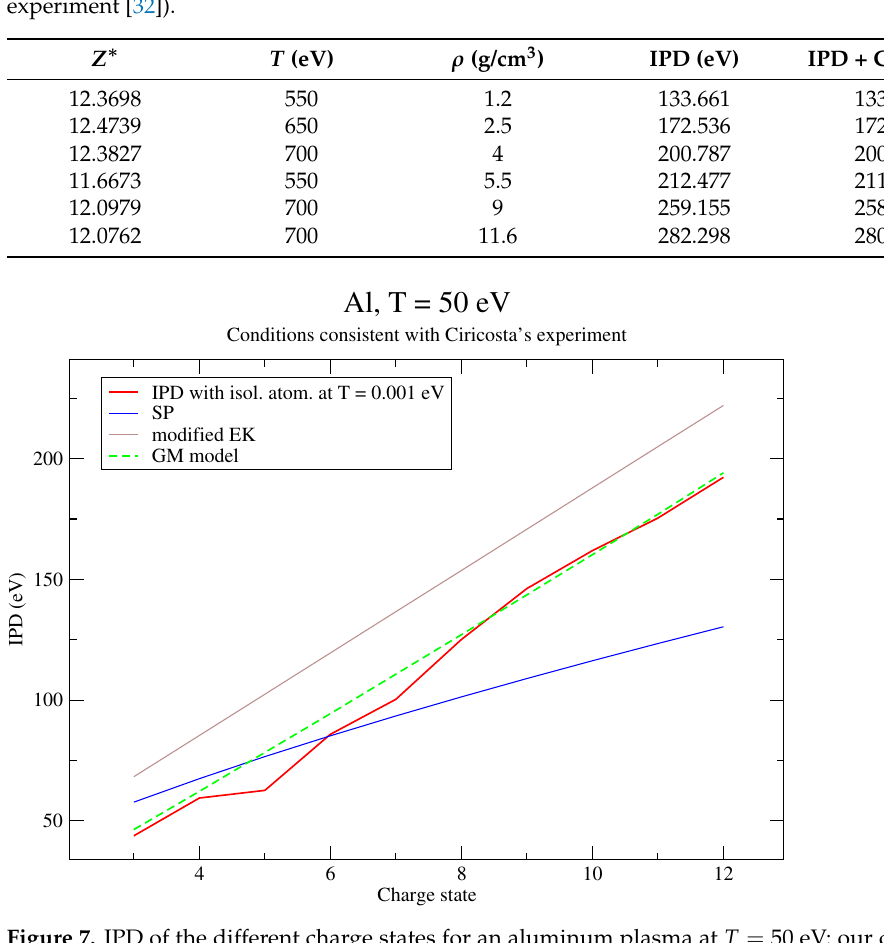
Figure 7. IPD of the different charge states for an aluminum plasma at T = 50 eV: our calculation (red curve), Stewart-Pyatt model (blue curve), modified Ecker-Kröll model (brown curve) and GM model (green dashed